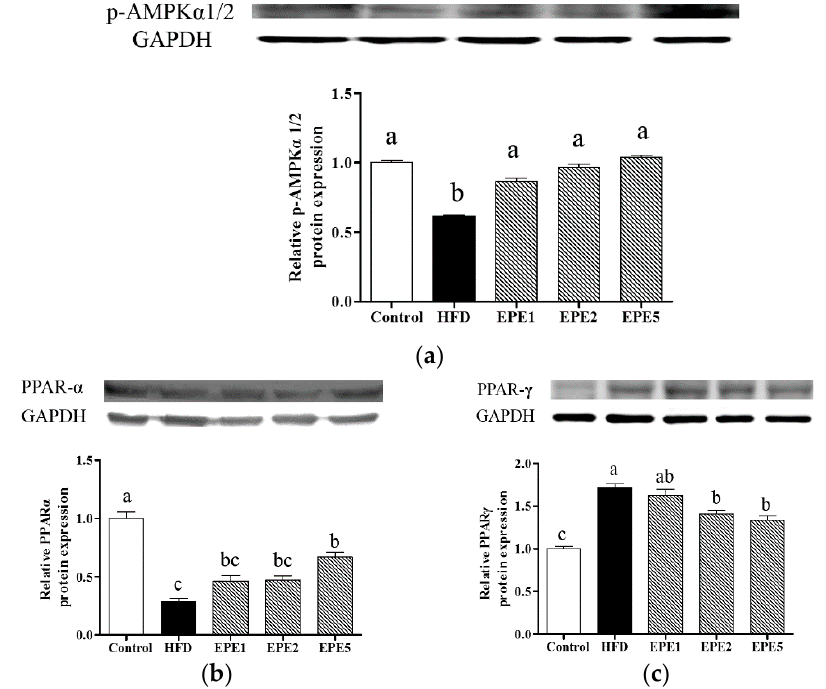
Figure 7. Effects of Echinacea purpurea ethanol extract on liver protein expression of ( a ) Phospho- Adenosine Monophosphate-Activated Protein Kinase Alpha 1/2 (p-AMPK α 1/2), ( b ) Peroxisome Proliferator-Activated Receptor Alpha (PPAR- α ), and ( c ) PPAR- γ in HFD-induced obese rats after 5 weeks. Data are shown as the mean ± S.E.M. (n = 5). The values with different superscript letters ( a – c ) are significantly different ( p < 0.05), as determined via one-way ANOVA, and were analyzed by Duncan’s multiple range